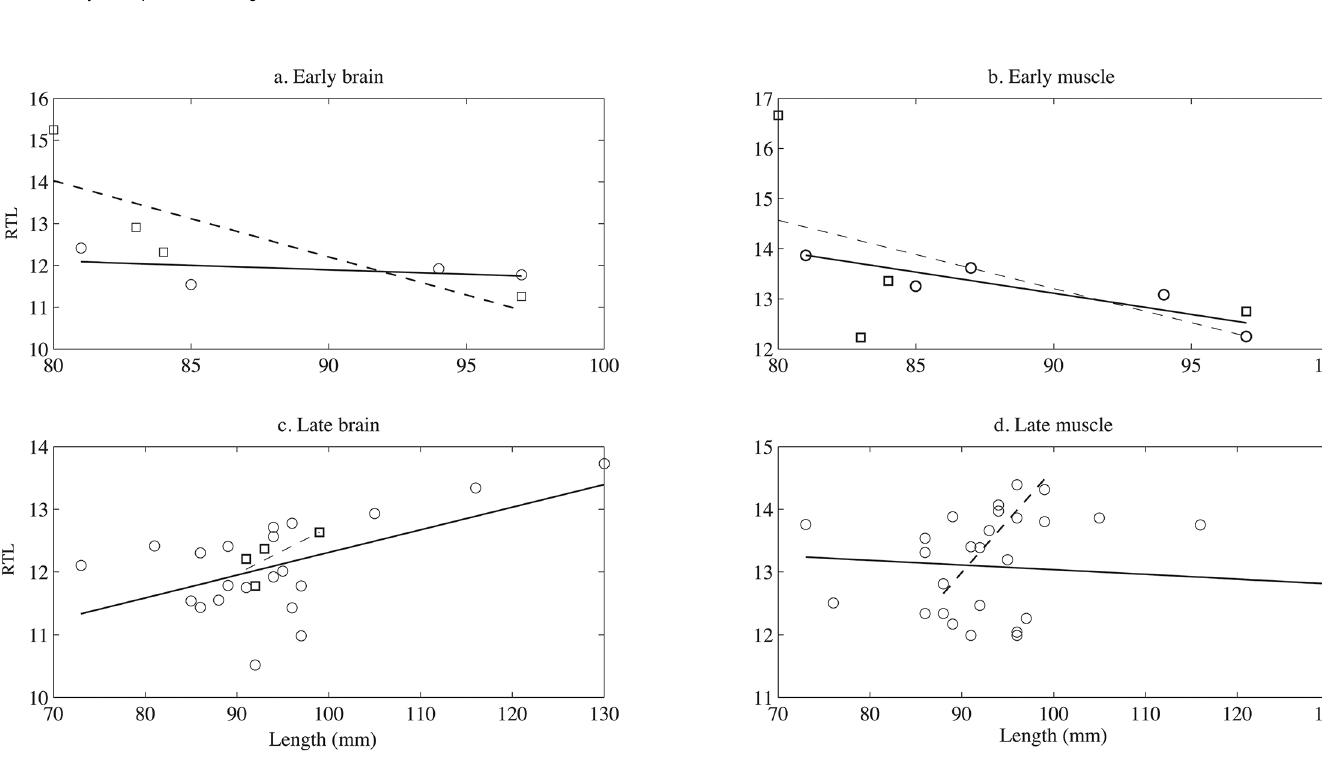
PLOS ONE | DOI:10.1371/journal.pone.0125674 May 4,